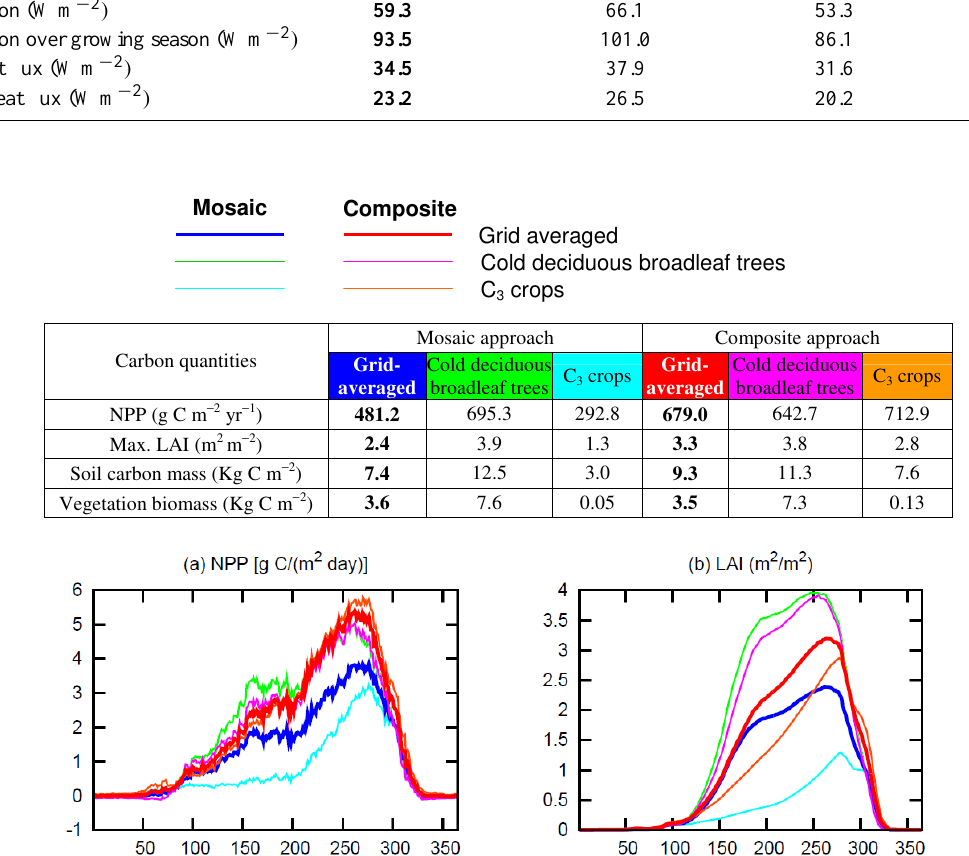
Fig. 6. Simulated daily averaged values of (a) NPP and (b) LAI for the Eastern US location for individual PFTs and grid-averaged values when using the two approaches. The table at the top summarizes the average annual values of NPP, vegetation biomass, soil carbon mass, and annual maximum values of LAI when using the two